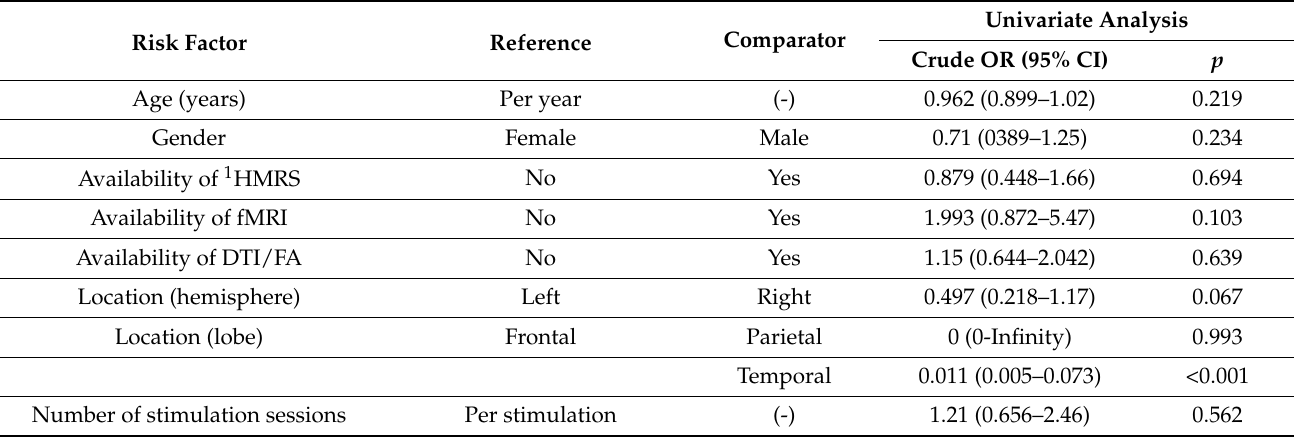
Figure 4. The extent of resection was influenced by the anatomic location of the glioma. Table 2. The univariate logistic regression analysis according to generalized linear models showed that the location of the tumor (lobe) and the total intra-operative blood loss were predictors for tumour